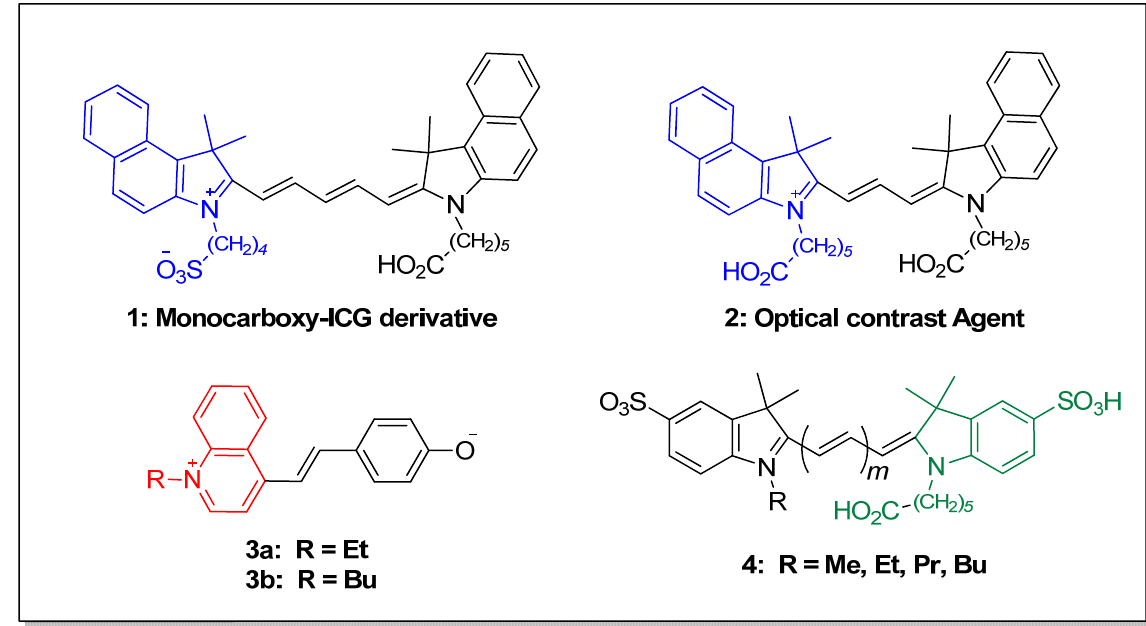
Figure 1. Dyes with widespread